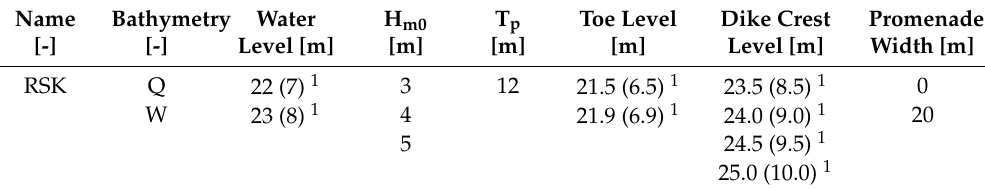
Table 1. Variation of test parameters and the values.